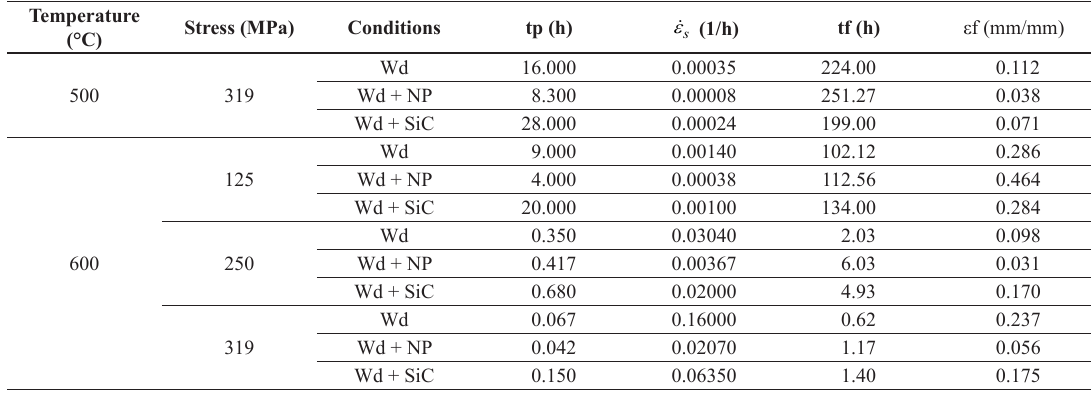
Table 3. Ti-6Al-4V creep test results in the conditions untreated (Wd) 21 , plasma nitrided (Wd+NP) 13 and SiC coated (Wd+SiC) 22 . Temperature